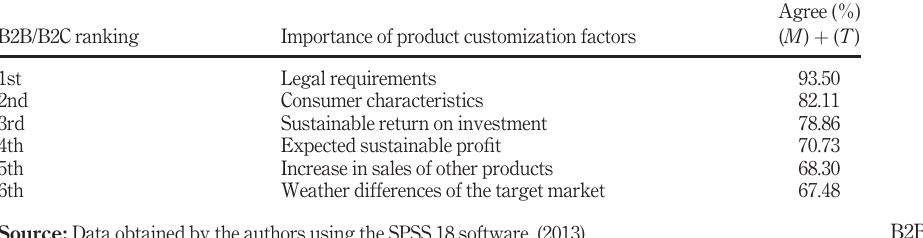
Table IV. B2B þ B2C